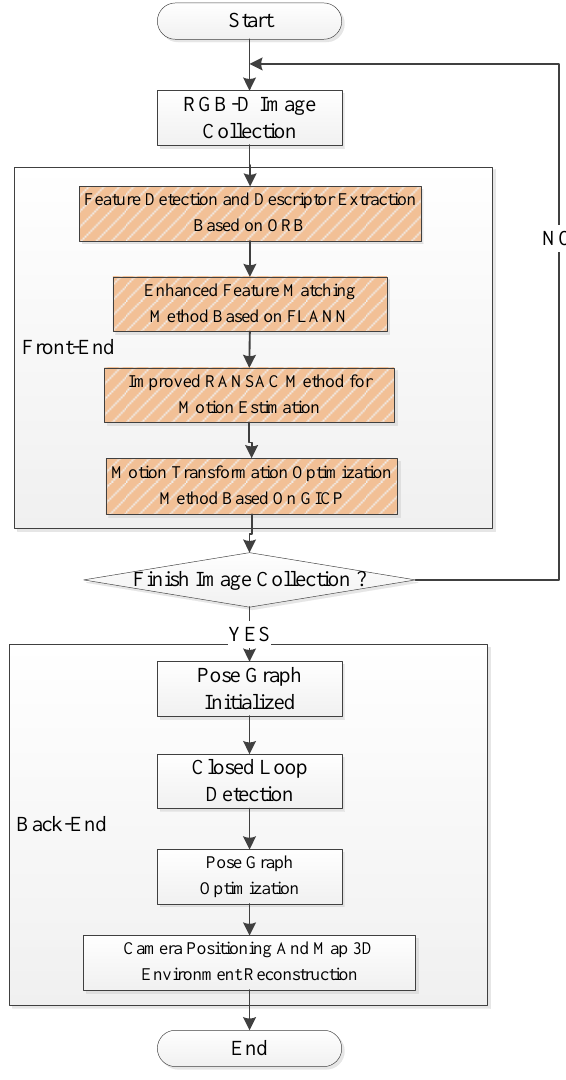
Figure 3. The process for improved RGB-D SLAM